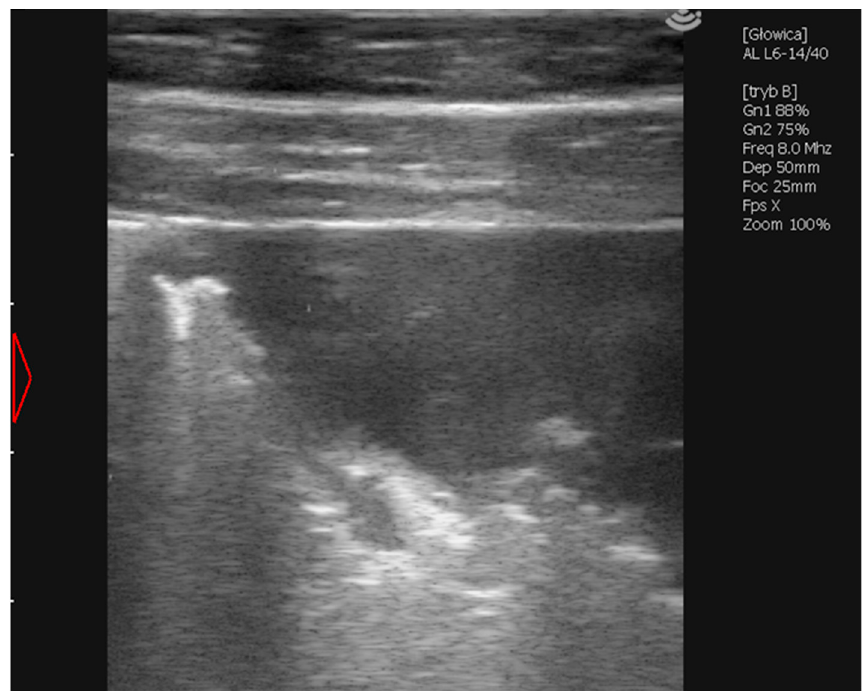
Figure 1. Ultrasonographic picture of an irregular abscessation observed in the right lobe from 9th ICS cranially during the first examination of Case 1. Visible parts of the abscess are 35.6 mm in width and 21.7 mm in depth.